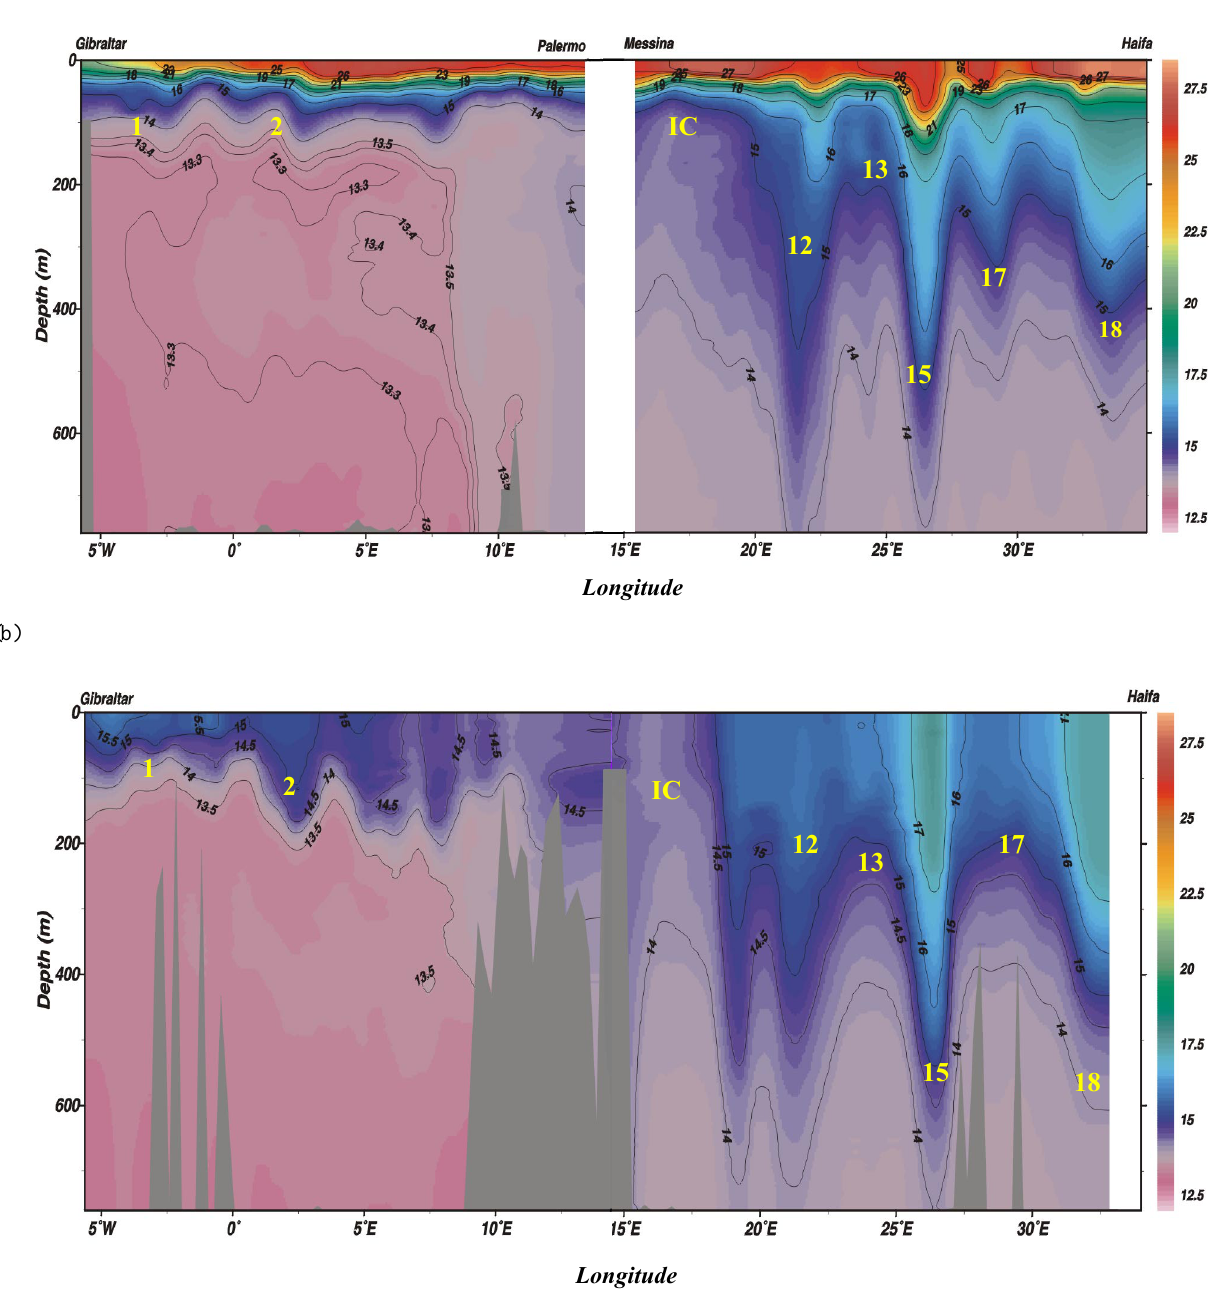
Figure 3b Fig. 3. Temperature vertical sections (a) from Gibraltar to Palermo (track 1a) and from Messina to Haifa (track 1b) in September 1999; (b) from Gibraltar to Haifa (track 1) in February 2000. Numbers and letters indicate the observed features (see also Fig. 1): 1-Western Alboran Gyre, 2-Algerian Current, IC-Ionian Cyclone, 12-Pelops Anticyclone, 13-Cretan Cyclone, 15-Ierapetra Anticyclone, 17-Mersa-Matruh Gyre, 18-Shikmona